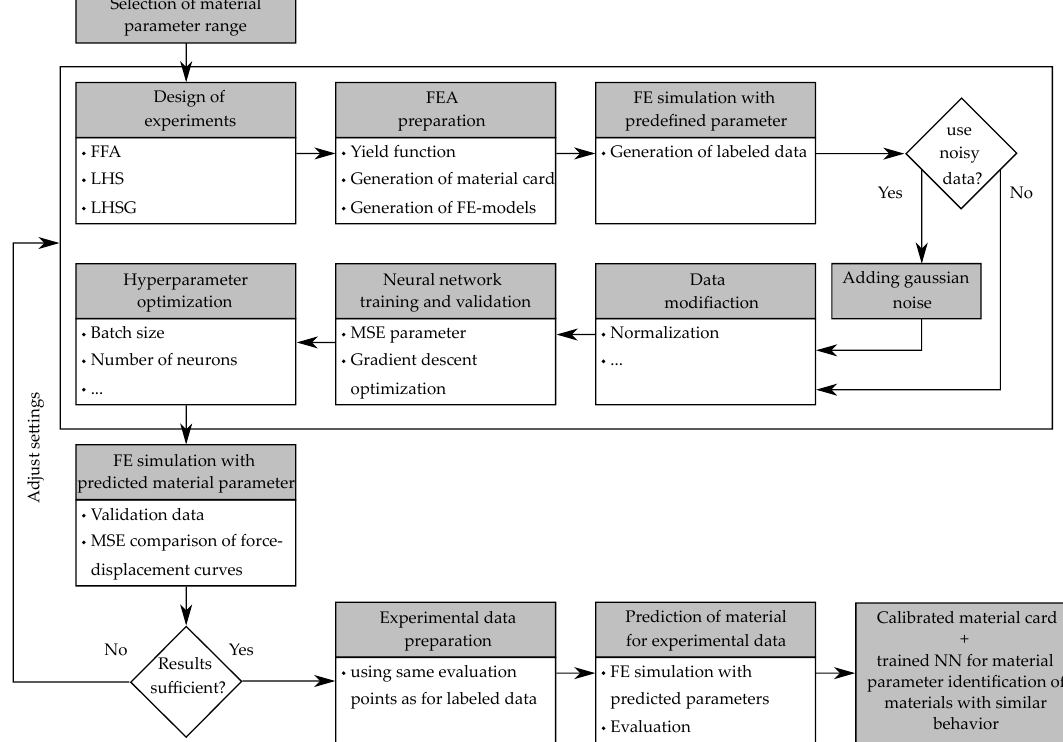
Figure 2. Workflow of the used direct NN-based parameter identification procedure applied to the problem of identifying the material parameters of the custom yield curve formulation for MAT024